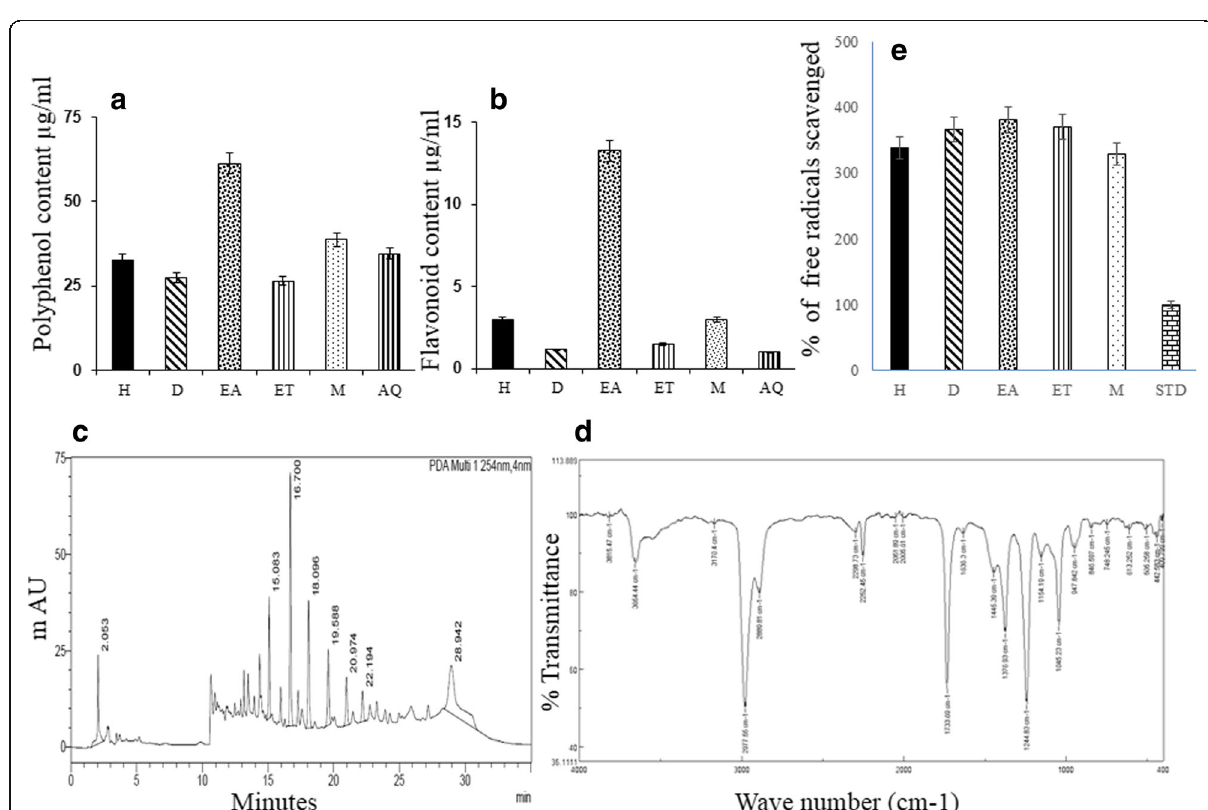
Fig. 1 Characterization of algal phytoconstituents. a and b Quantification of polyphenols and flavonoids in algal extracts reveals maximum concentration in ethyl acetate extract. c . HPLC analysis of ethyl acetate extract shows the presence of 4 compounds with retention time. d FTIR analysis of ethyl acetate extract showing presence of functional groups. e Analysis of antioxidant activity by DPPH assay reveals maximum antioxidant efficiency of ethyl acetate extract. Values expressed are Mean ± S.D. (H- hexane, D- Dichloromethane, EA- ethyl acetate, ET- ethanol, M- methanol, AQ - aqueous, STD- Ascorbic